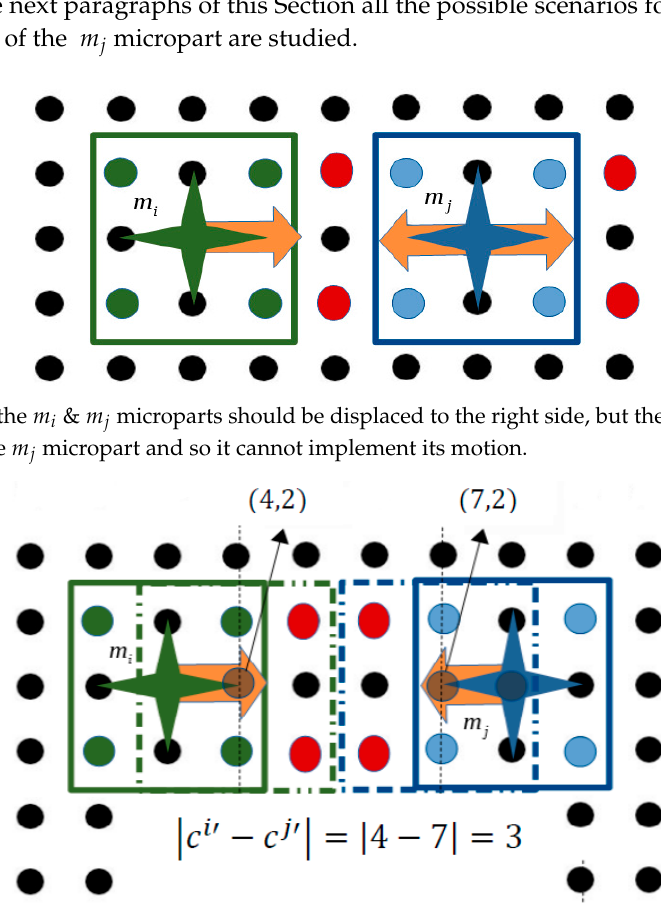
Figure 16. Both the (cid:1865) (cid:3036) & (cid:1865) (cid:3037) microparts should be displaced to the right side, but the activation for